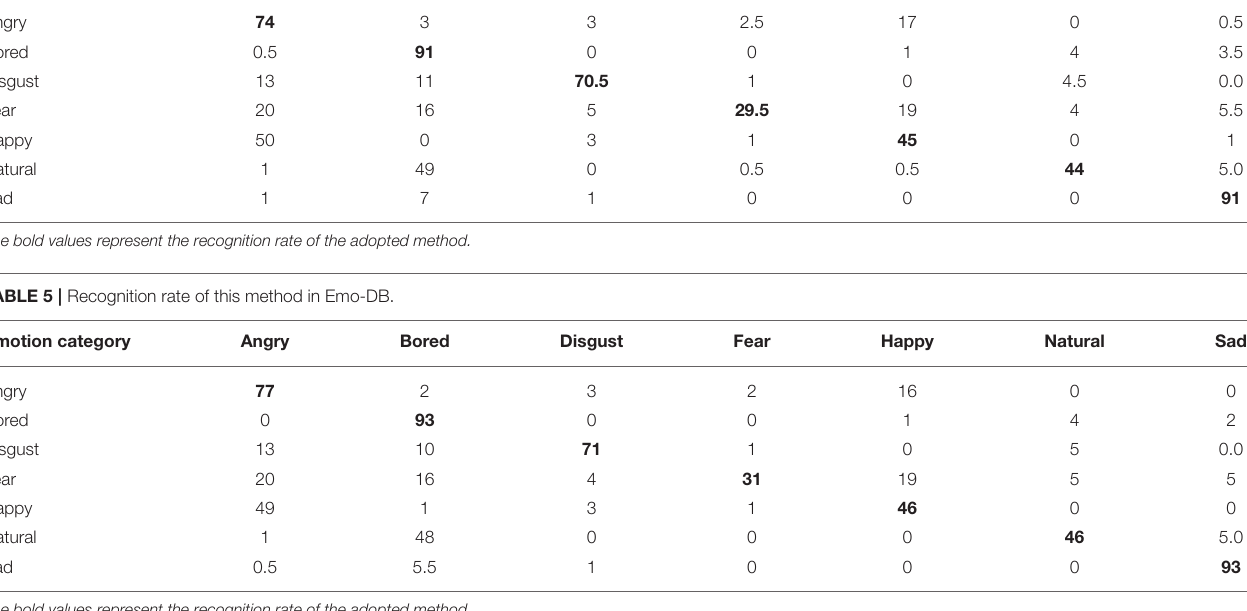
The bold values represent the recognition rate of the adopted